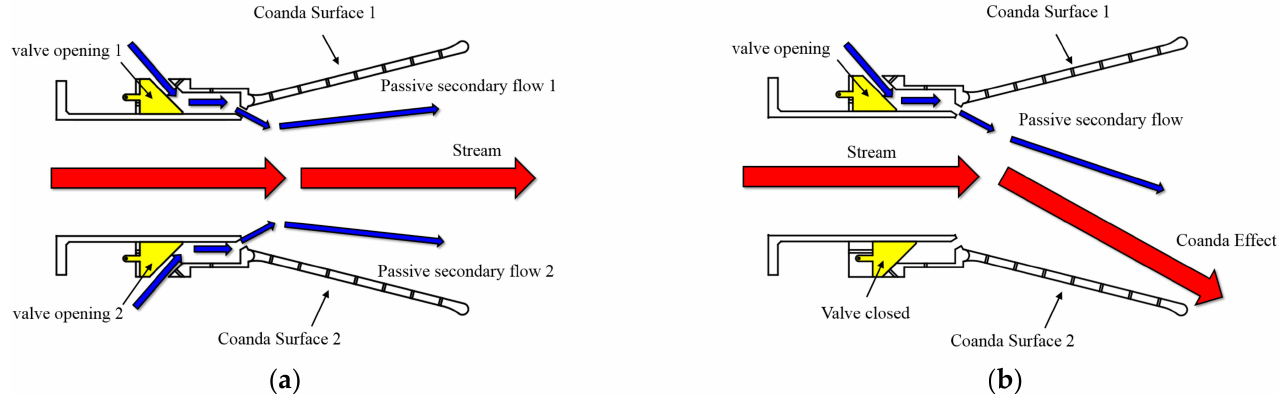
Figure 1. Structure diagram of passive thrust vector. ( a ) Flow structure diagram of a jet under detachment condition; ( b ) flow structure diagram of jet deflection wall attachment condition.